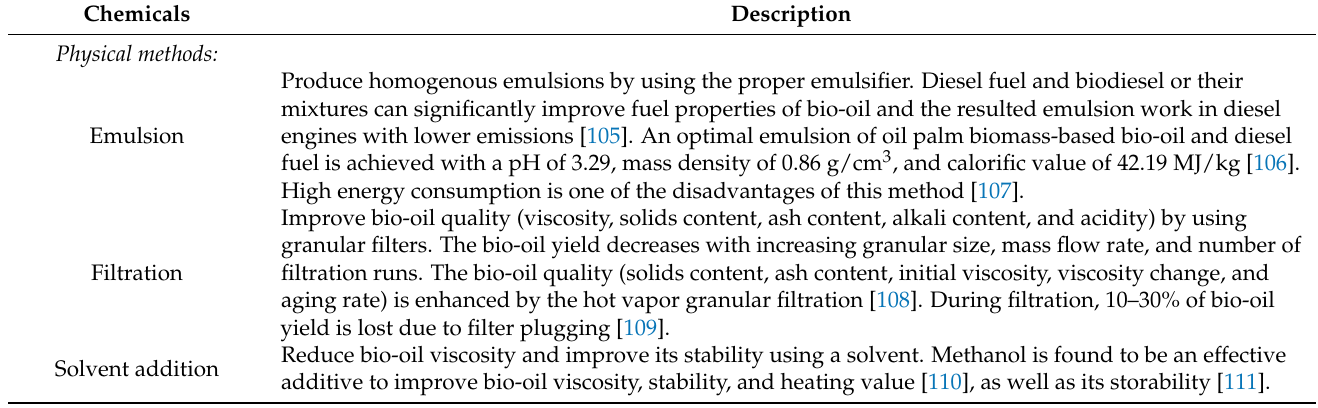
Table 7. Summary of the promising route to upgrade pyrolysis oil to produce